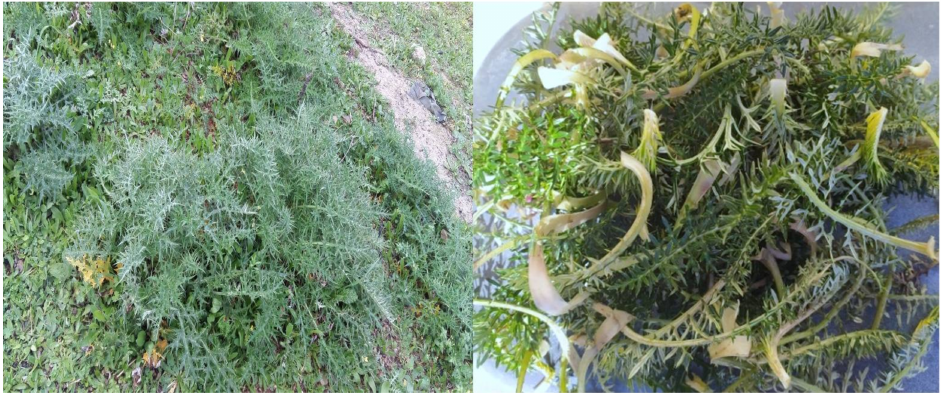
Figure 2. The plant studied, Cynara humilis